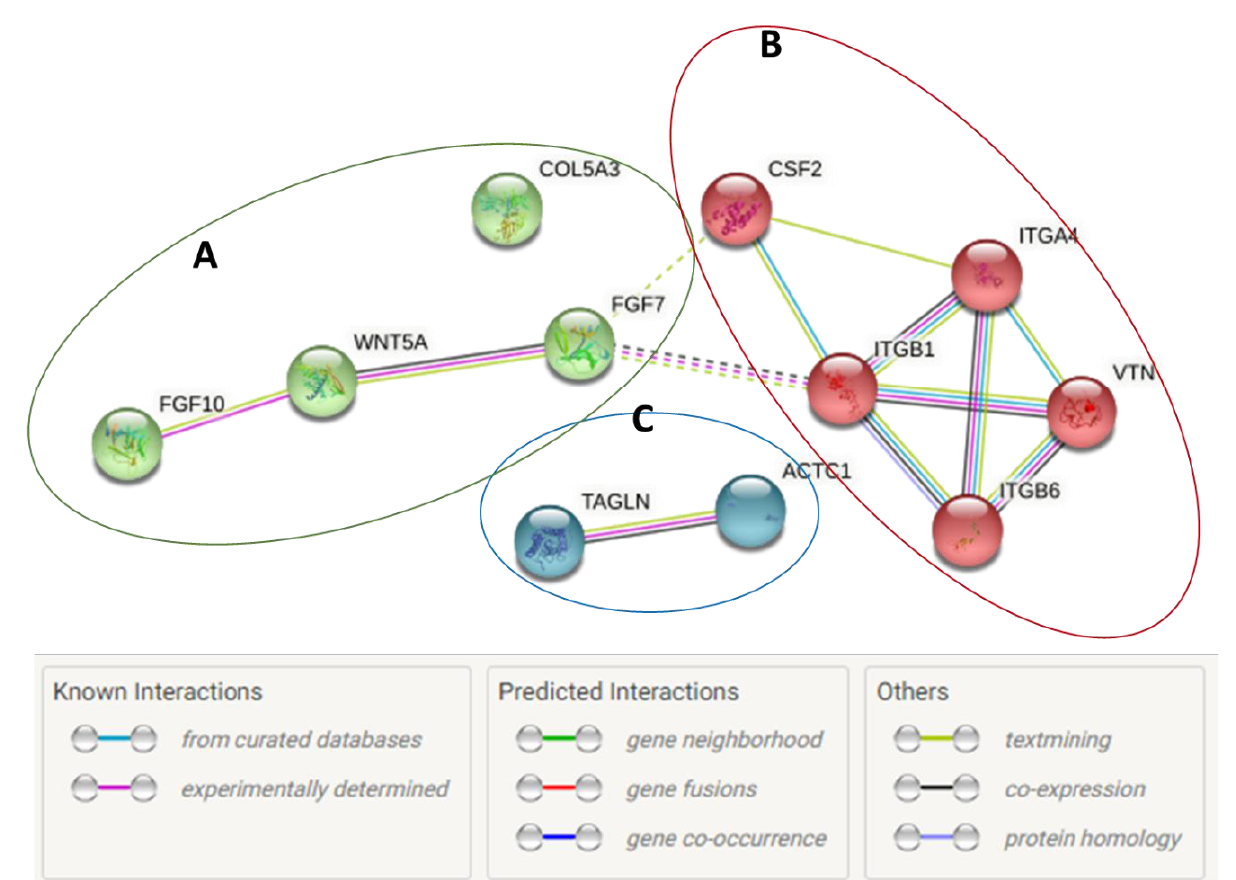
Figure 9. Protein networks showing the interactions between DEGs expressed in KMST-6 cells treated with C. orbiculata water extract. These networks were determined using the STRING database.